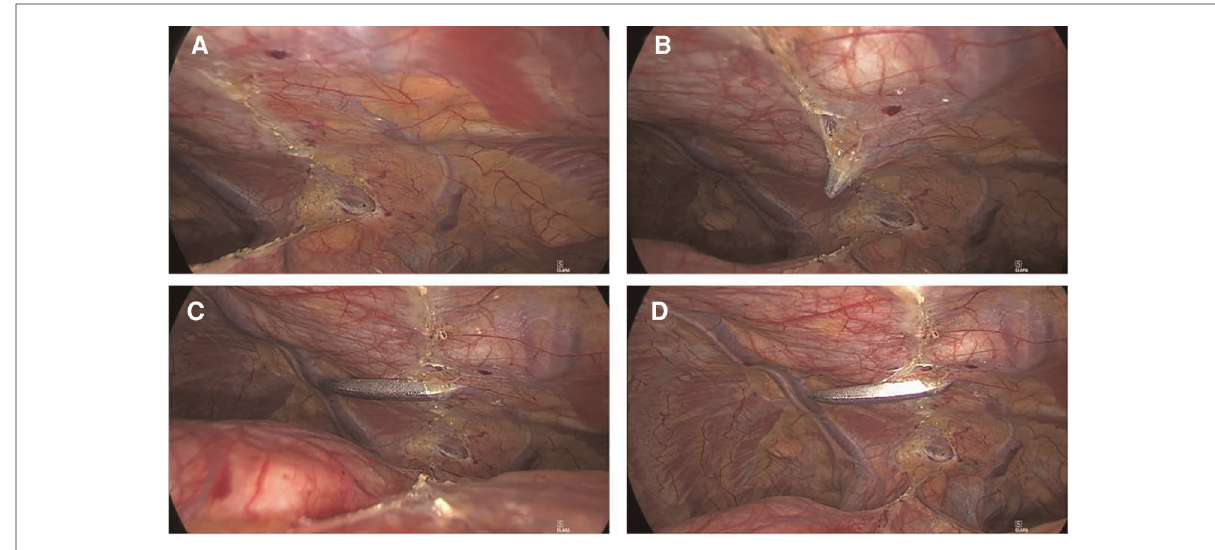
FIGURE 2 Enlarged operative space after placement of a sternal retractor. A sternal retractor was placed in the second intercostal parasternal position to elevate the sternum and enlarge the operative space.